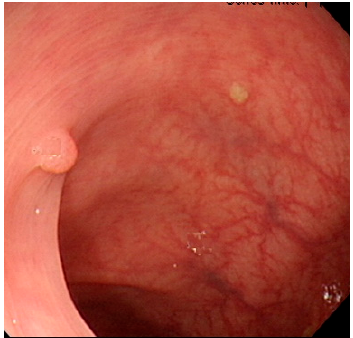
Figure 2. Excessive intestinal wall textures with small polyps.